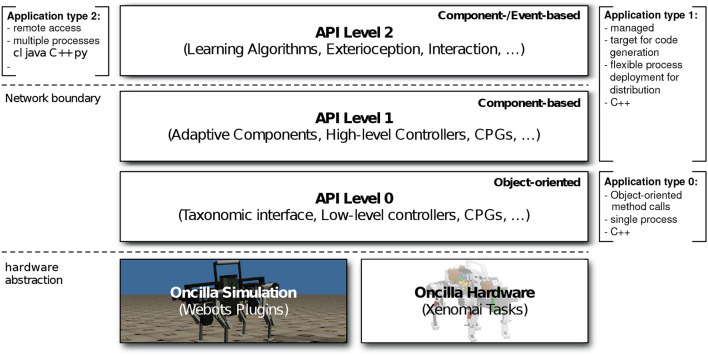
Schematic presentation of the three-layered Oncilla application programming interface (API). API levels 0–1 for local access, API level 2 for extended language and tool support over the network.